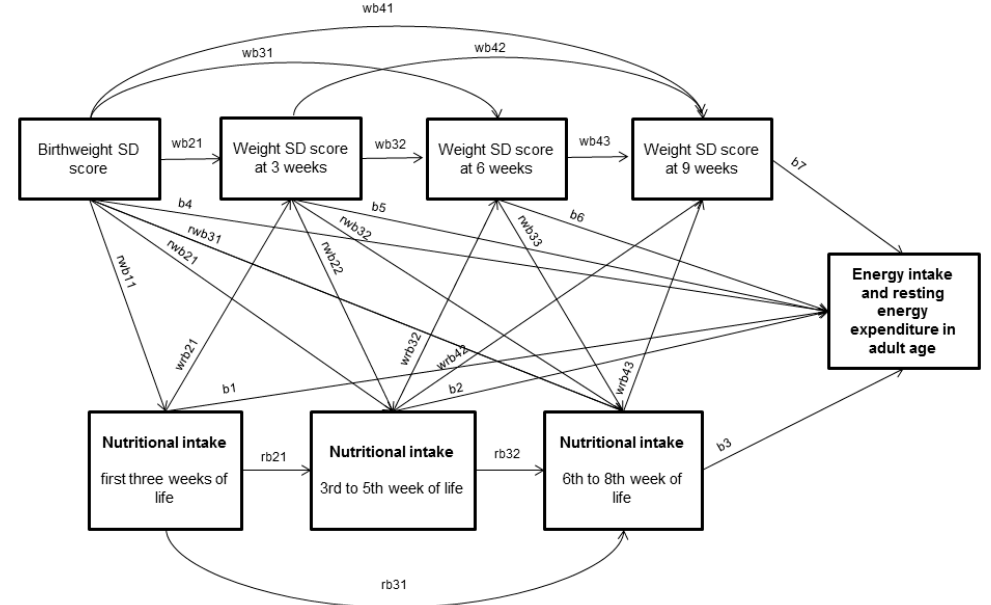
Figure 1. Hypothetical full path model for neonatal nutrient intake with three time points, body weight with four time points and relative energy intake in adult age. Paths are labeled using following abbreviations: wb* for paths between weight SD scores, rb* for paths between nutritional intake variables, rwb* for paths from weight SD scores to nutritional intake variables, wrb* for paths from nutritional intake variables to weight SD scores and b* for paths from weight SD scores and nutritional intake variables to adult age outcome. For wb and rwb paths, “*” represents the order of variables from left to right of both dependent and explanatory variable.